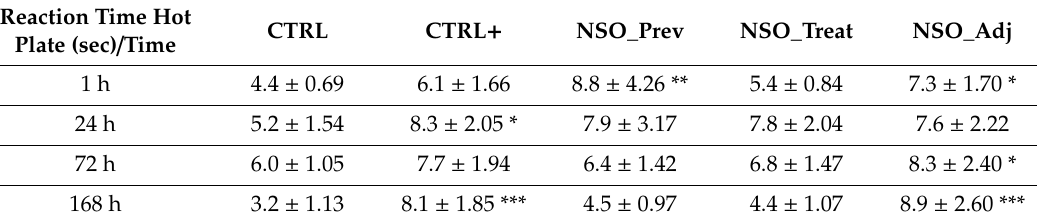
Table 8. Analgesic e ff ect of NSO on the sub-acute inflammation rat